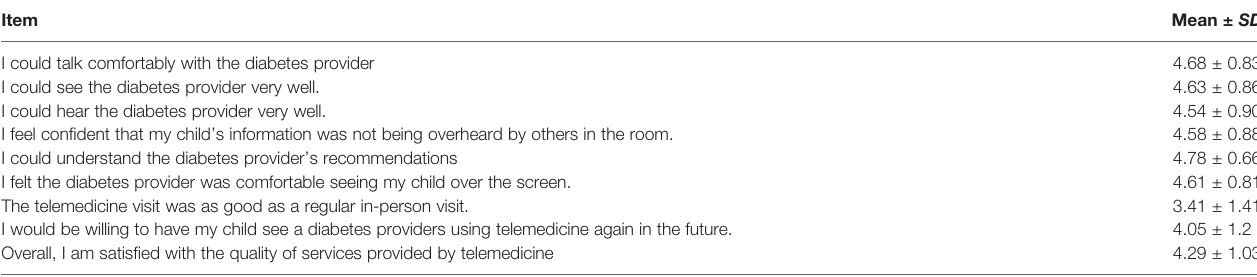
TABLE 2 | Parent-reported satisfaction with diabetes telemedicine visit.